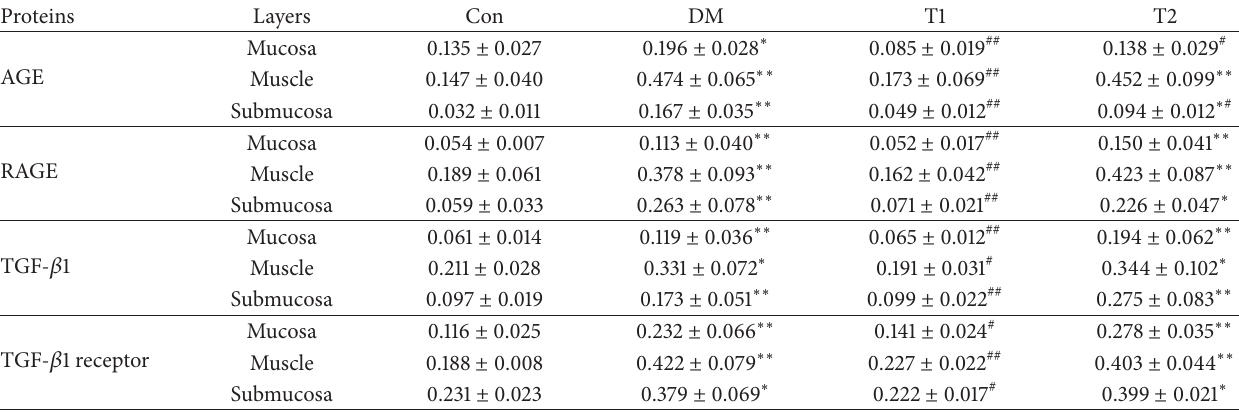
Table 3: Fractions of AGE, RAGE, TGF- 𝛽 1, and TGF- 𝛽 1 receptor expressions.